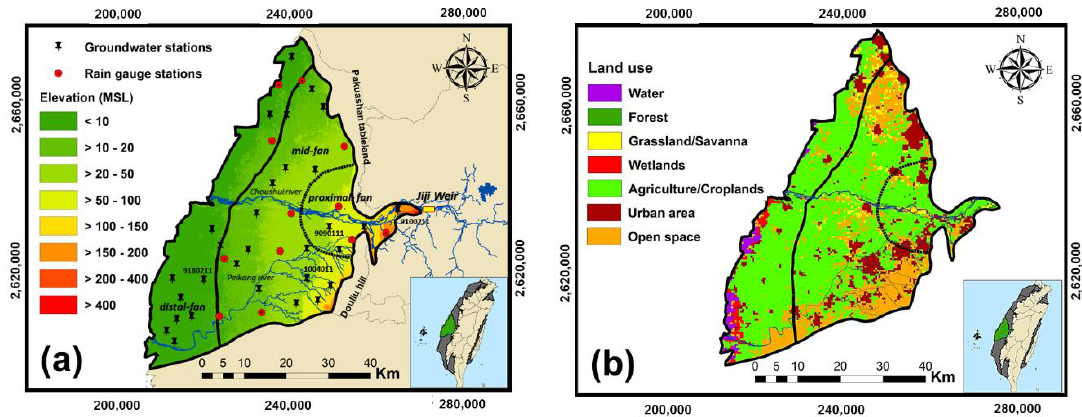
Figure 1. ( a ) The study area in Choushui River groundwater basin (CRGB) and the monitoring well locations for the first-layer groundwater level and precipitation (Central Geological Survey (CGS): The World Geodetic System (WGS) 1984 The Universal Transverse Mercator (UTM) Zone 51N); ( b ) the land use map for the CRGB based on the MODIS Land Cover Type product (MCD12Q1) provided by the United States Geological Survey (USGS).